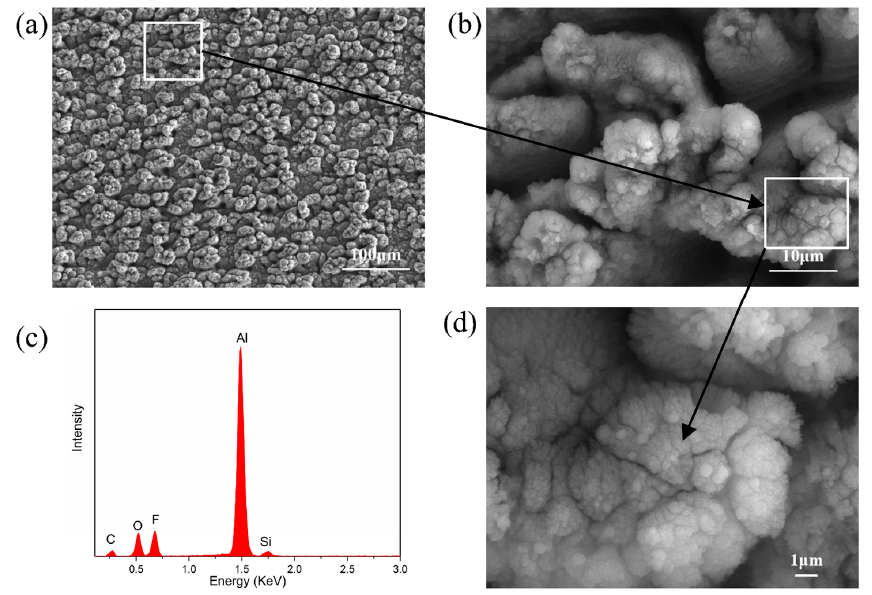
Figure 2. ( a , b , d ) scanning electron microscopy (SEM) microstructure of laser processing; ( c ) Energy dispersive spectrum (EDS) of the superhydrophobic surface.